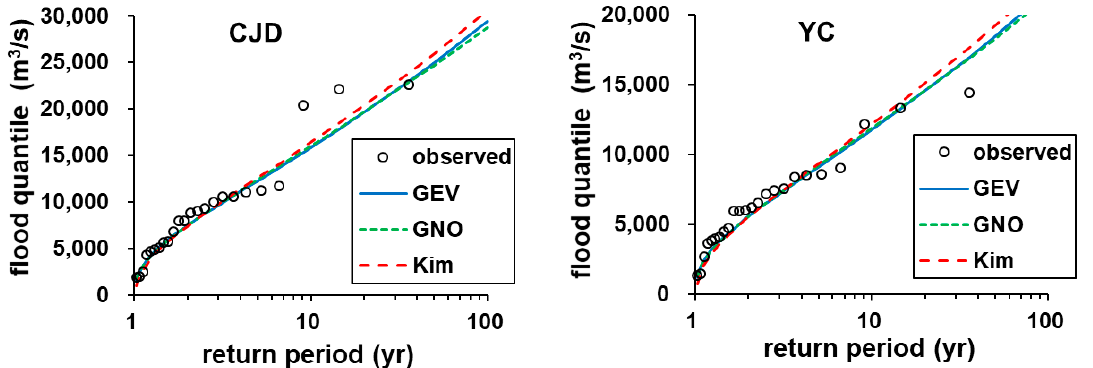
Figure 7. Comparison of flood quantiles. Kim is the result of Kim et al. [17].